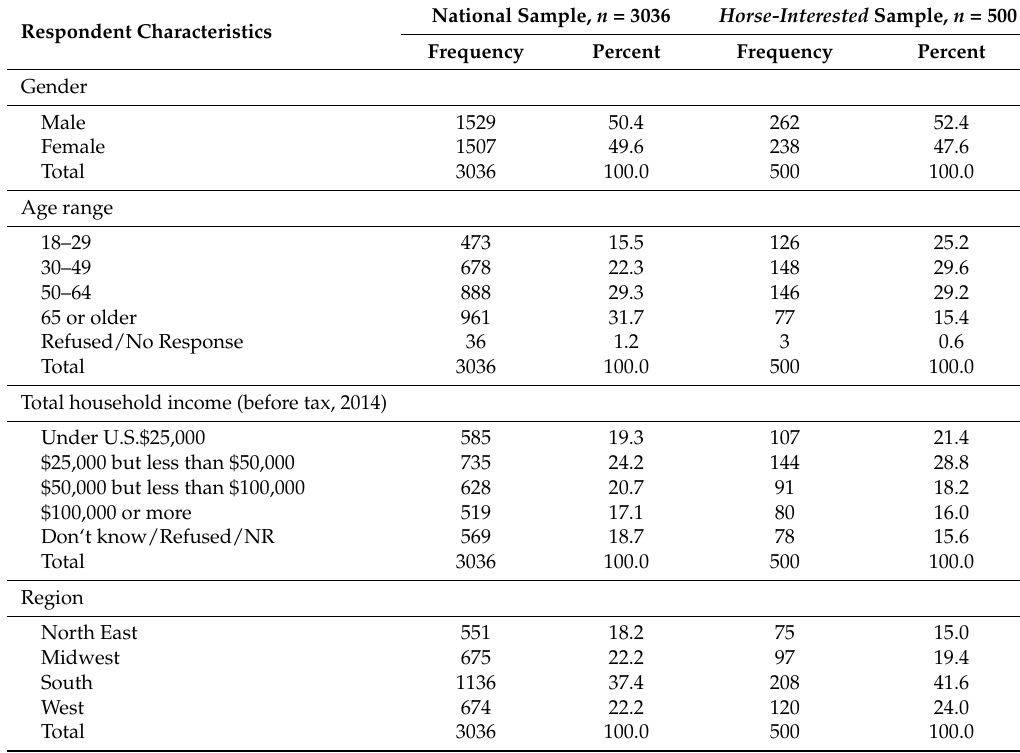
Table 1. The unweighted frequencies and percentages for the nationally representative sample of 3036 respondents and the 500 who were horse-interested